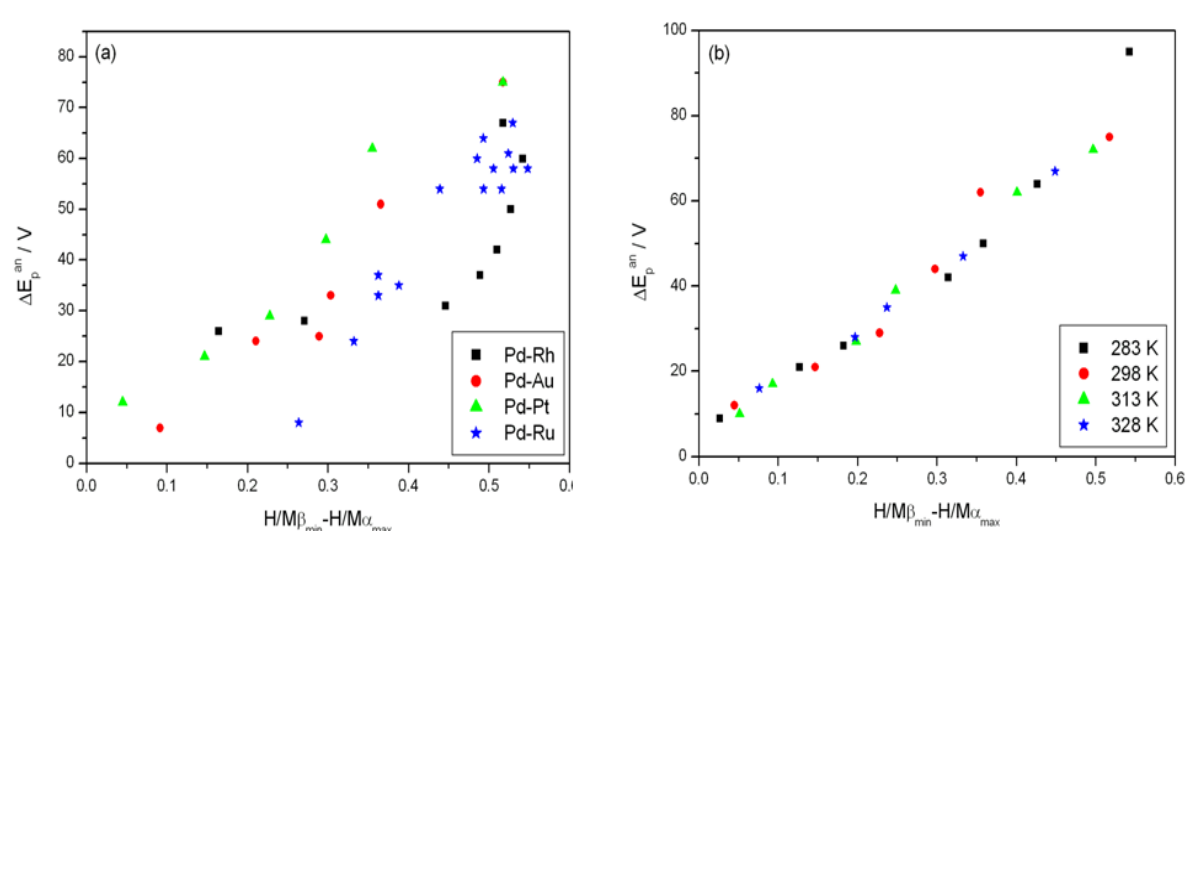
Figure 8. Correlation of the difference between minimum value of the potential of anodic peak 2 just before the phase transition and its final value at low electrosorption potentials (ΔE pan ) with the difference in H/M ratio at phase boundaries: ( a ) for various alloys at 298 K; ( b ) at various temperatures for Pd-Pt